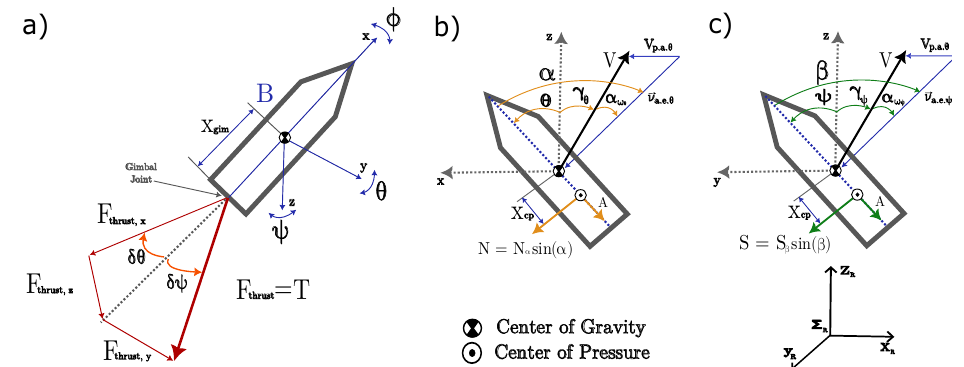
Figure 4. ( a ) Rocket with an integrated TVC, with a bounded angle nozzle, and the aerodynamics forces shown in ( b ) the xz-plane, and ( c ) the yz-plane. Notice that CoG and CoP are at different locations, which yields a rather highly nonlinear coupled non-affine underactuated